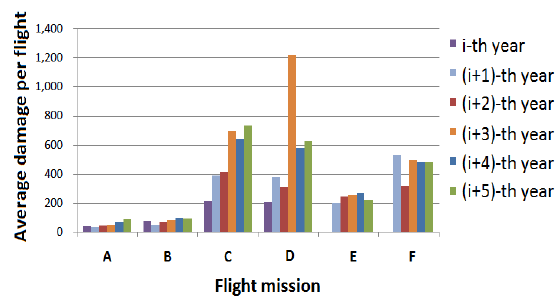
Figure 7. Variation of annual damage for flight subjects.